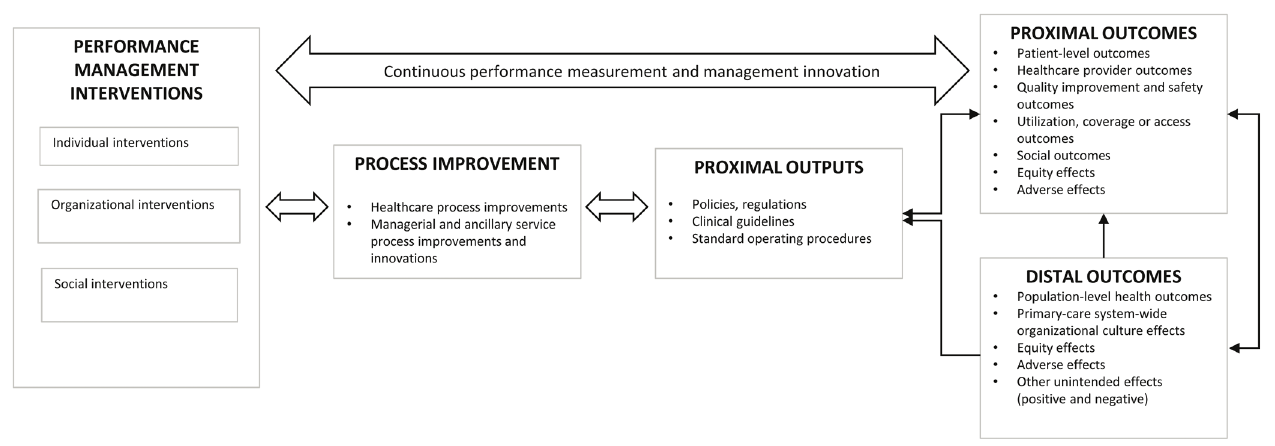
Figure 2. Performance measurement and management framework in primary care delivery